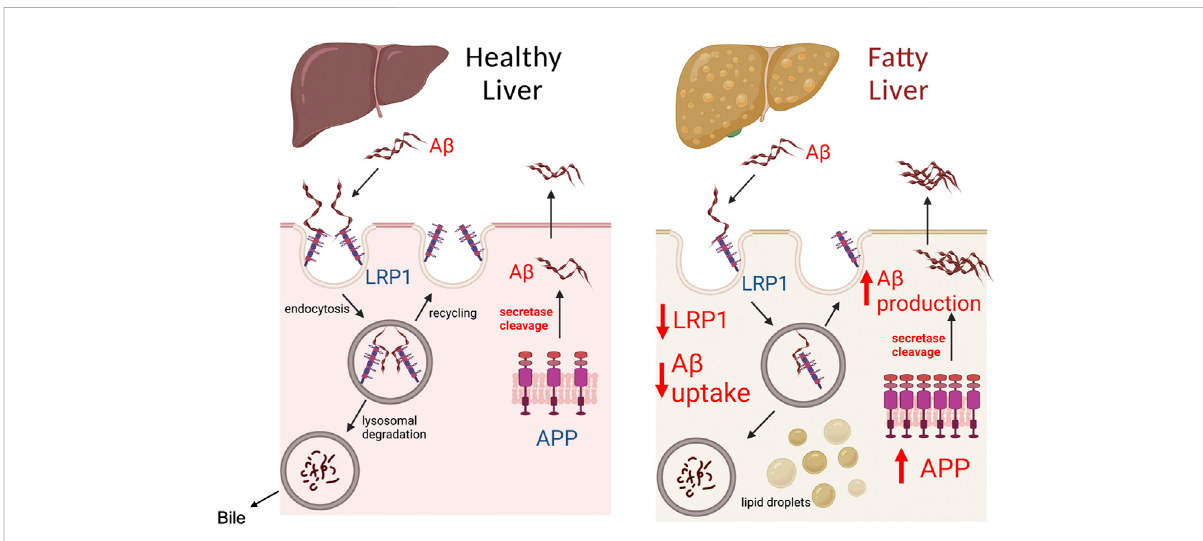
Model of A β processing by healthy and fatty liver. The liver plays a signi fi cant role in determining A β load in the peripheral organs and blood, as both a source of A β and by clearing A β . LRP1 in the liver has been identi fi ed as the major receptor responsible for A β clearance from the blood. A β binding to LRP1 is believed to trigger endocytosis and uptake of A β inside hepatocytes, where it is degraded by lysosomes, and secreted in bile. Modulation of LRP1 in the liver has been shown to affect the capacity of the liver to clear A β from the periphery. The liver also contains APP, which through the action of secretases such as PSE2, can be cleaved to A β causing its release into circulation. A healthy liver is likely to consume or produce low levels of A β , unless there are geneticmutations suchas PSE2 mutations. Inthe caseof fatty liver (steatosis), our work demonstrates that LRP1 levels are inhibited by ~50% and APP expression is increased 2-fold. The decreased LRP1 and increased APP expression during liver steatosis likely makes the liver an important source of A β in the blood and liver, which can increase A β levels in the brain to promote AD. Created with